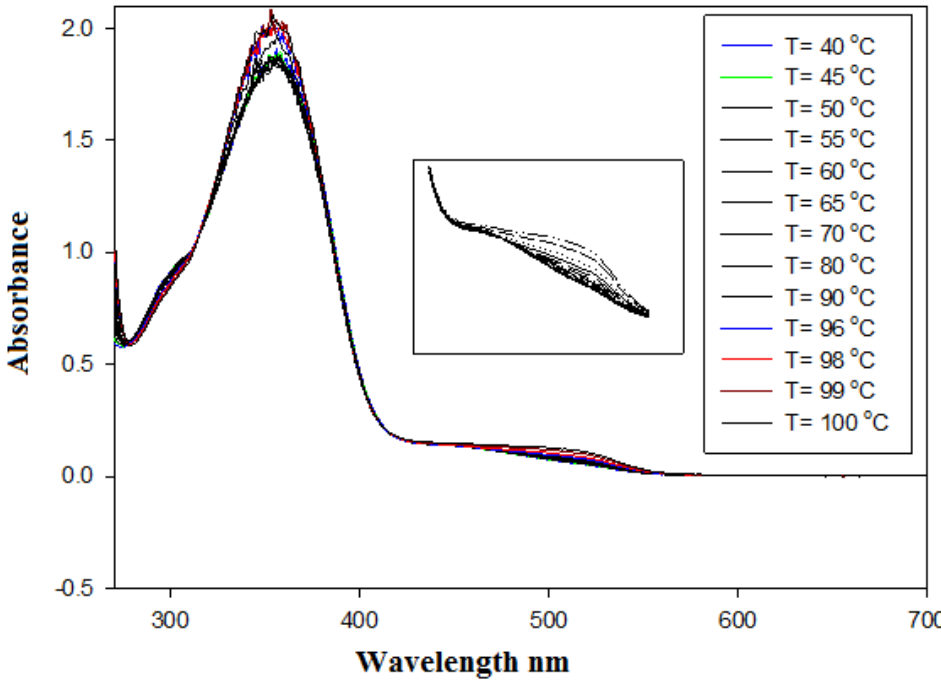
Figure 11. UV absorption spectrum of SMHB complex I12/B in DMF with a heating range from 25 to 100 °C.